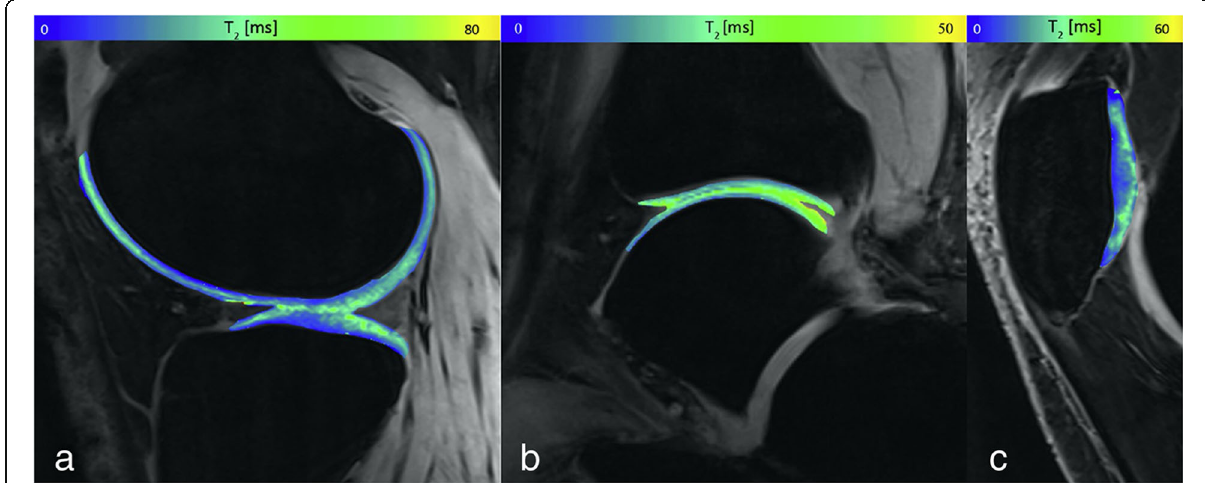
Fig. 4 T2 maps of cartilage of the knee ( a ), ankle ( b ), and patella ( c ) of pseudo-colour-coded three-dimensional triple echo steady state three- dimensional triple-echo steady state overlaid on the second acquired image (F 0 , the lowest order steady state free precession - free induction decay mode acquired in the repetition time). Reprinted with permission from: Juras et al, Eur J Radiol 2016 (reference